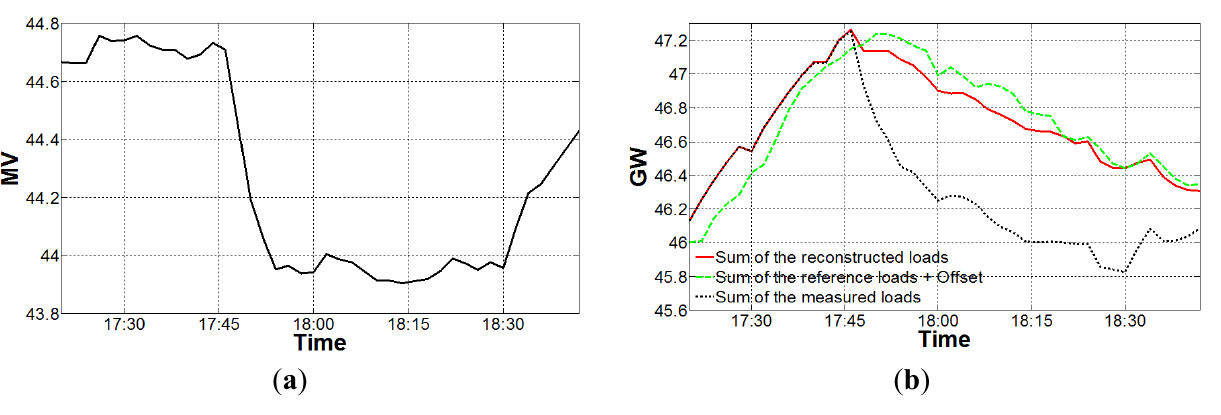
Figure 7. Results of the nationwide CVR implemented on 20 November 2012: ( a ) sum of 1936 bank voltages; and ( b ) sum of 1936 transformer-bank